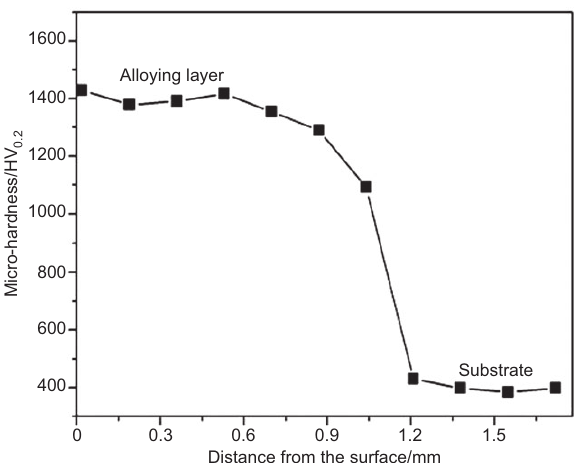
Figure 5 Microhardness distribution of the composite coating in the